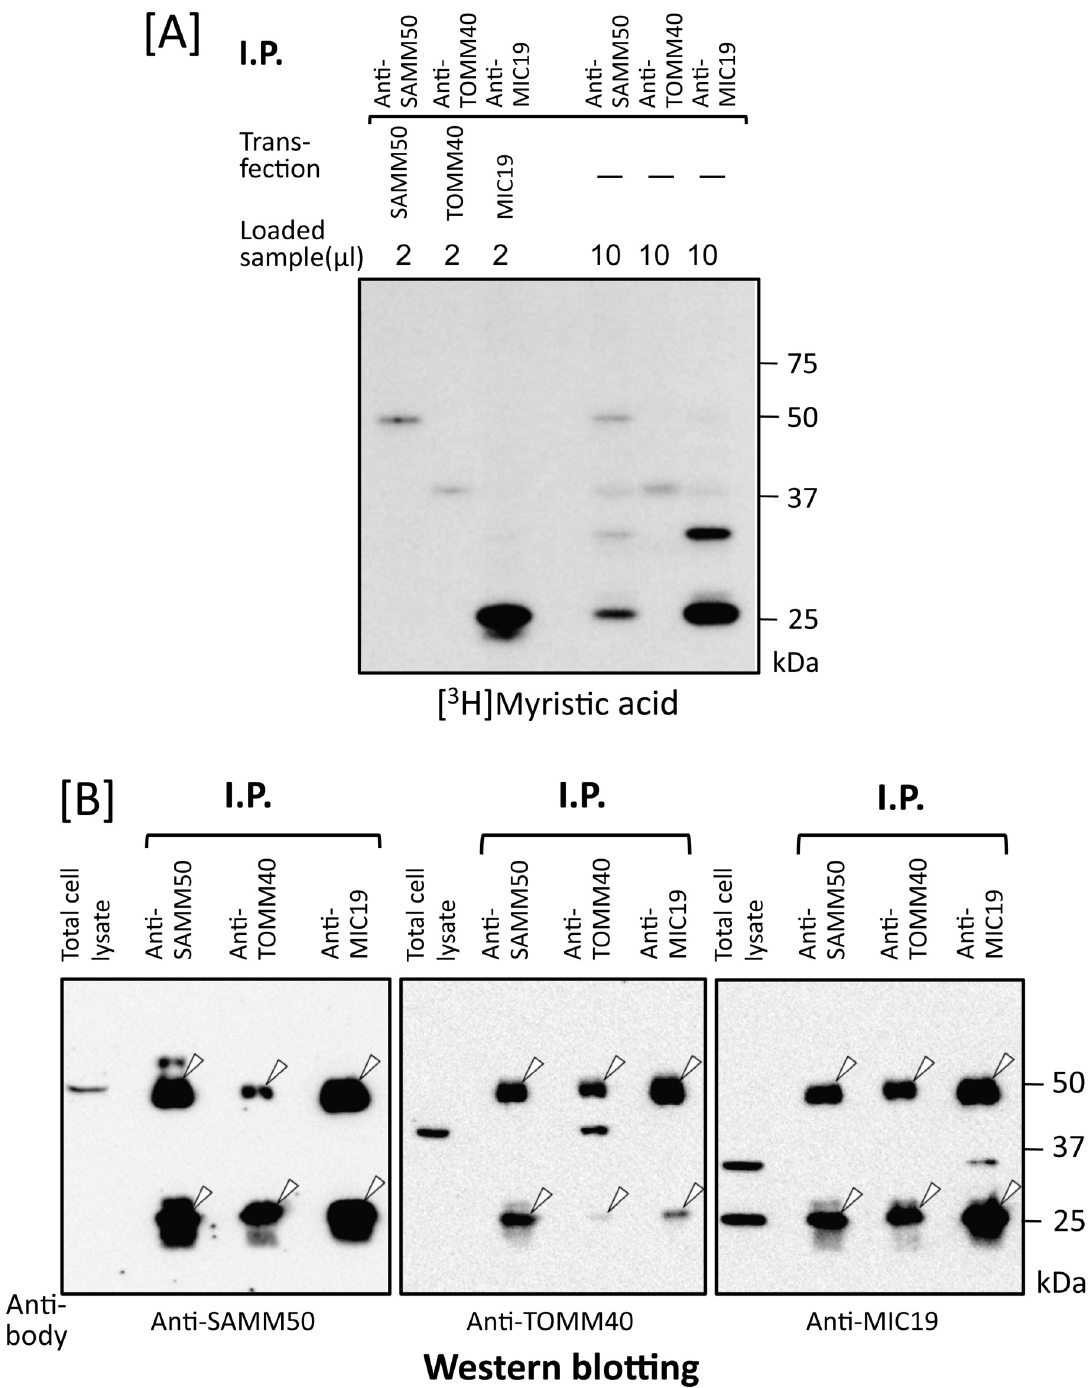
Fig 5. Identification of MIC19 as a major N -myristoylated binding partner of SAMM50. A. Metabolic labeling of N -myristoylated proteins expressed in COS-1 cells with [ 3 H]myristic acid followed by immunoprecipitation with specific antibodies against SAMM50, TOMM40, and MIC19 was performed. The labeled proteins were separated by SDS-PAGE and then detected by fluorography (lanes 4–6). For this analysis, tag-free-SAMM50, -TOMM40, and -MIC19 exogenously expressed in COS-1 cells were used as controls (lanes 1–3). B. Western blotting analysis of immunoprecipitated samples used in A. Presence of endogenous SAMM50, TOMM40, and MIC19 in the immunoprecipitated samples used in A lanes 4–6 was determined by western blotting analysis. For this analysis, total cell lysates of COS-1 cells were used as control (lanes 1, 5, and 9). Arrowheads in B indicate the position of heavy- and light-chains of IgG used for immunoprecipitation.